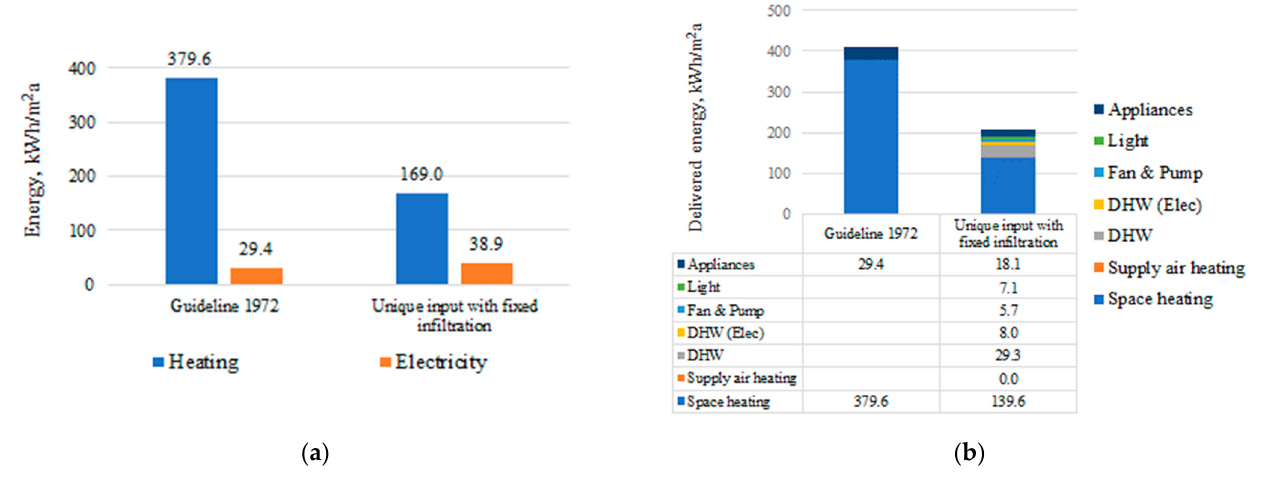
Figure 9. Comparison of energy use of a reference single family house with Finnish guideline 1972 house. ( a ) Heating and electricity from the guideline and calibrated model with fixed infiltration; ( b ) breakdown of energy use.